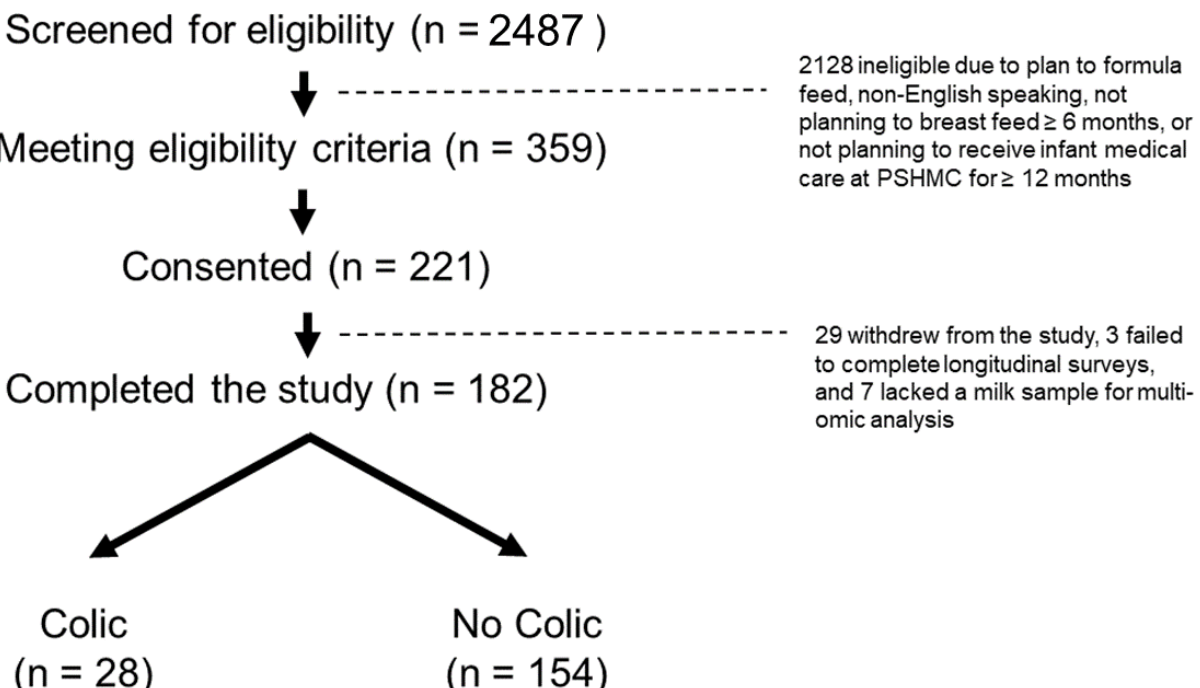
Figure 2. There were 2487 mother – infant dyads screened, 359 eligible dyads approached, and